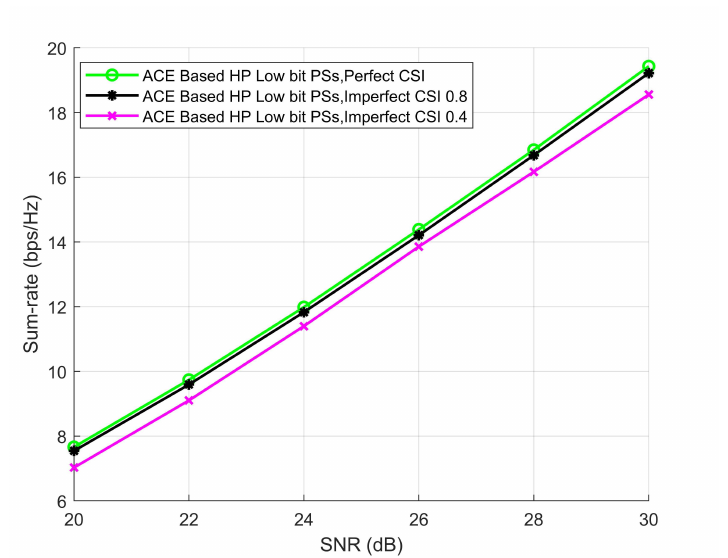
Figure 7. ACE-based HP with different CSI conditions (when C = A = 10 and users and RF chain =